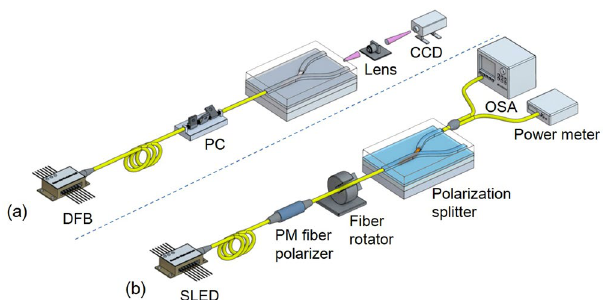
Figure 2. Integrated optic device characterization setup for ( a ) output mode image observation consisting of DFB laser, fiber-optic polarization controller (PC), polarization splitter, objective lens, and CCD image sensor, and ( b ) broadband spectral response measurement consisting of SLED light source, PM fiber polarizer, fiber rotation stage, polarization splitter device under test, optical spectrum analyzer and power